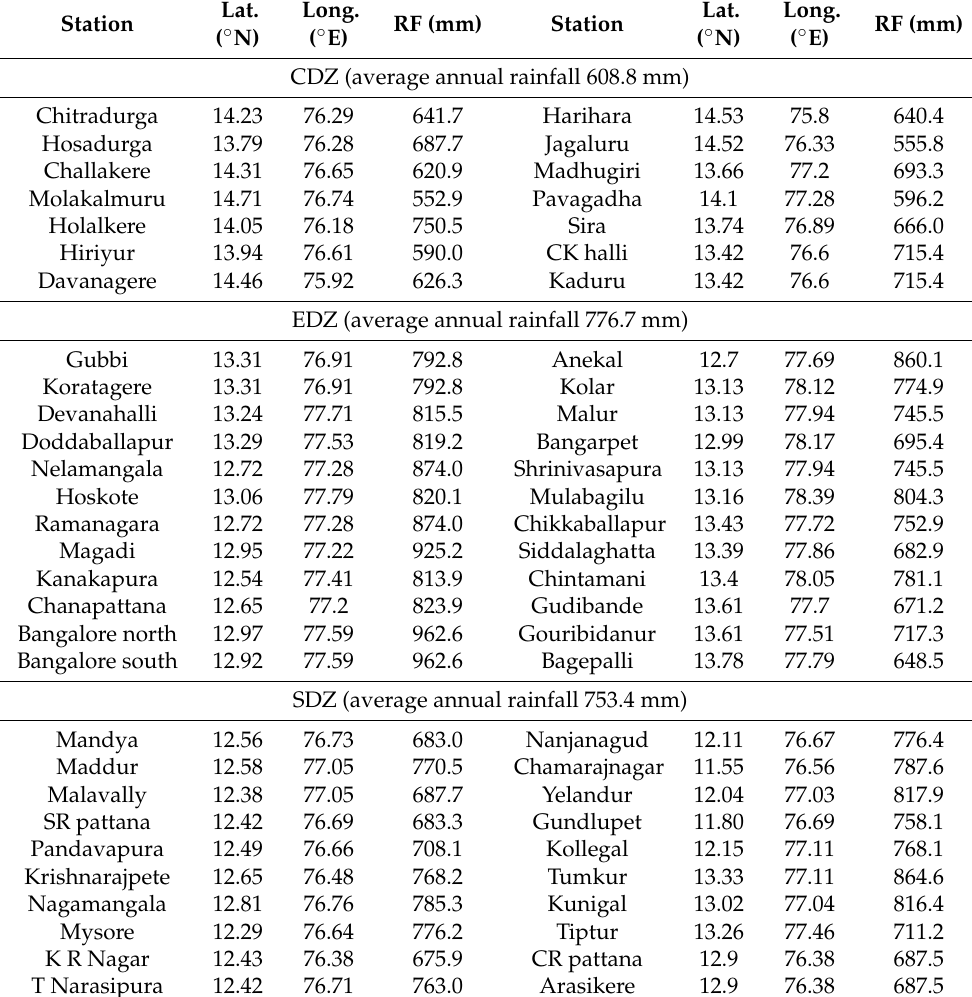
Table 2. The location of rain gauges and spatial variability of annual rainfall over